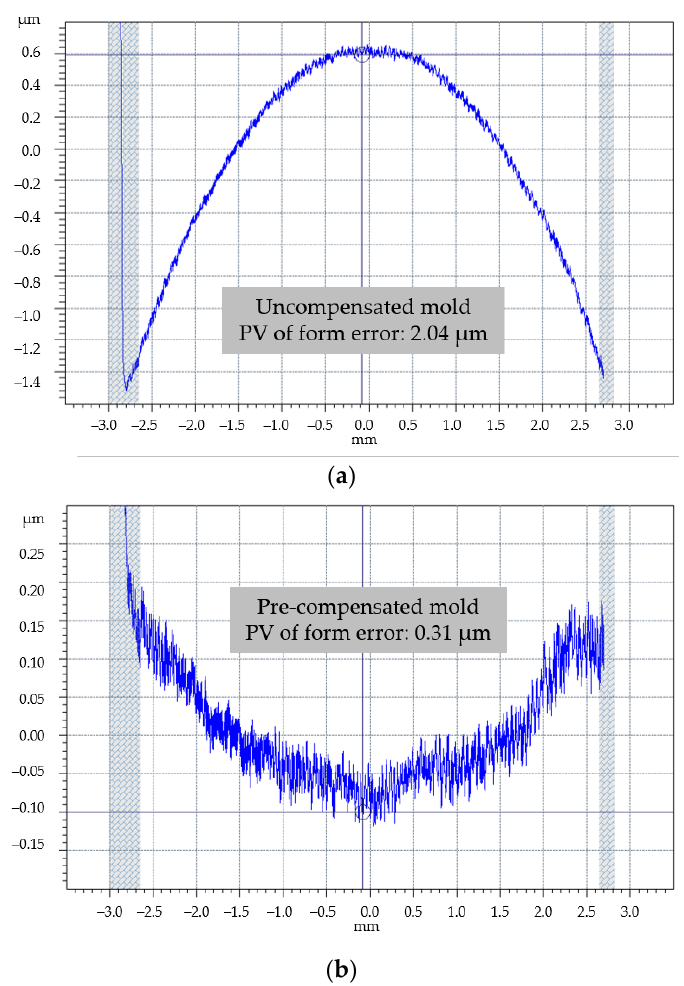
Figure 10. Peak valley (PV) values of aspheric surface form errors of the glass lenses molded by ( a ) uncompensated mold and ( b ) pre-compensated mold.